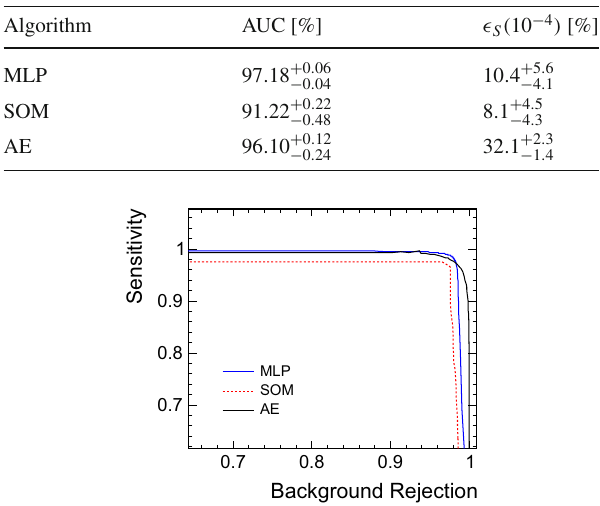
Fig. 18 ROCcurvefortheclassificationofhypotheticaldyons(signal) and beam background for three different algorithms. MLP multilayer perceptreon, SOM self-organising map, AE autoencoder